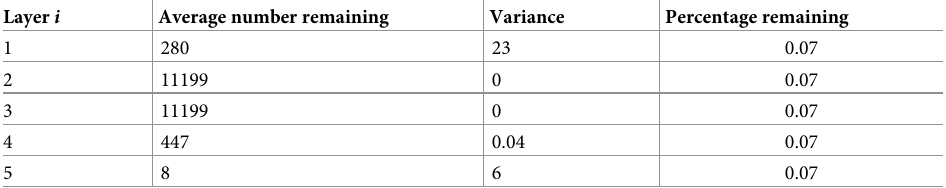
Table 1. Number of remaining parameters in networks pruned to 93% sparsity. This table gives the average number of remaining weights in each layer of the networks pruned to 93% sparsity. The variance on the number of connections, as well as the fraction of remaining connections are also